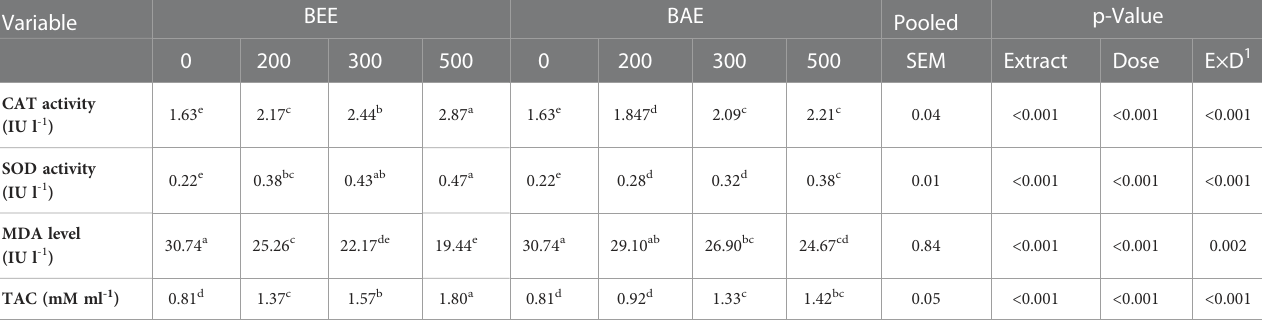
TABLE 8 Effect of dietary supplementation of basil ethanol and aqueous extracts (mg kg -1 of feed) on serum antioxidant status of Nile tilapia, O. niloticus .